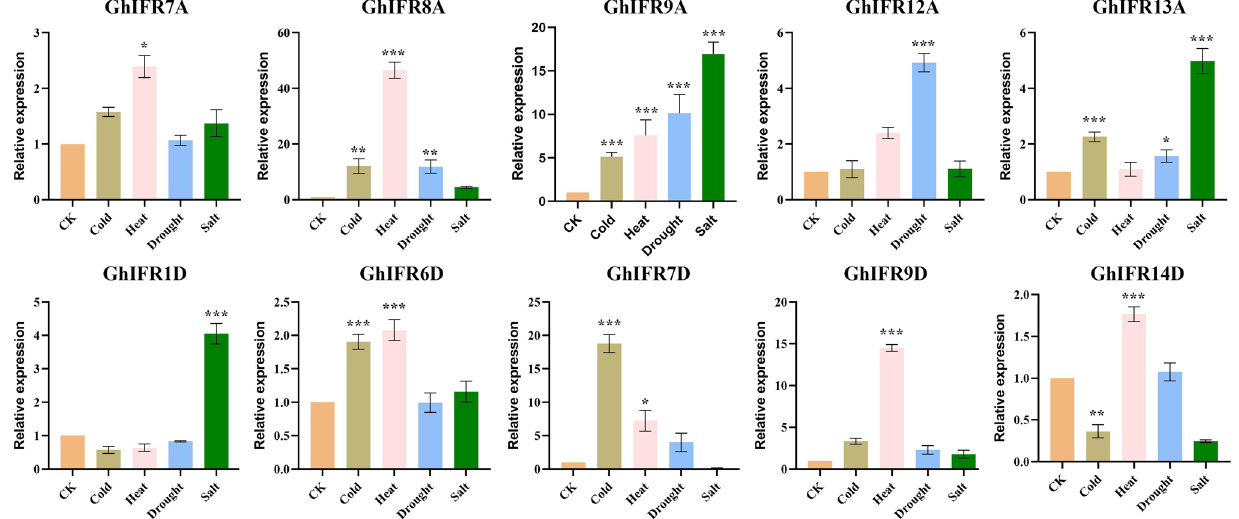
Figure 7. Analysis of the expression patterns of GhIFR genes under cold, heat, drought and salt stress by qRT- PCR. The mean values were from three independent biological replicates. Statistical analyses were performed by Student’s t-test (*P < 0.05 and **P <